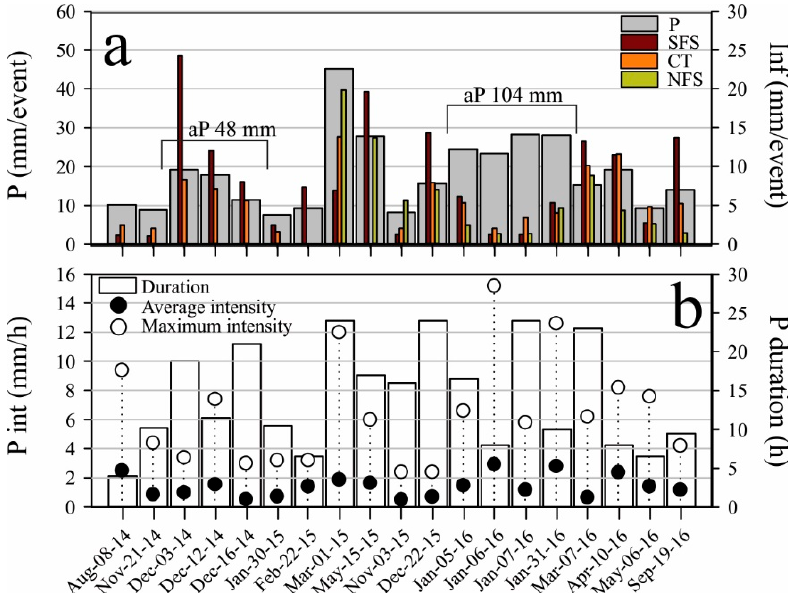
Figure 9. ( a ) The measured precipitation (gray bars) and estimated vertical infiltration at 0.1 m depth (color bars) per event at the three monitoring sites. ( b ) The average and maximum precipitation intensity (black and white circles, respectively) and the time duration of the selected precipitation events (white bars). aP represents accumulated precipitation.